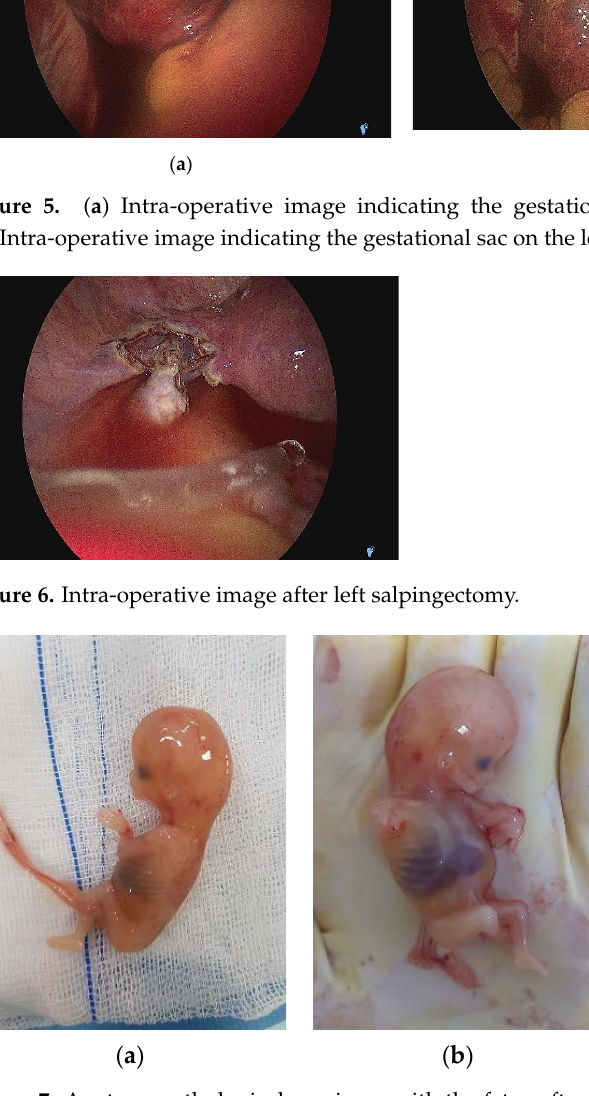
Figure 7. Anatomopathological specimen with the fetus after the removal of the tubal pregnancy from two distinct perspectives ( a , b ).